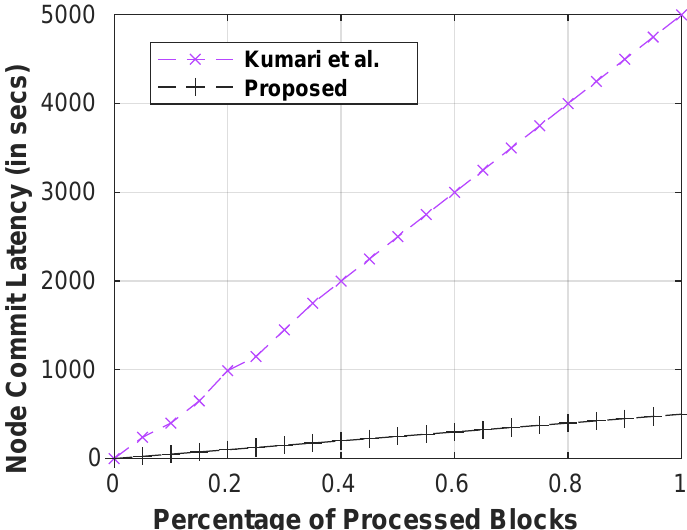
Figure 6. Comparative analysis of node commit latency.